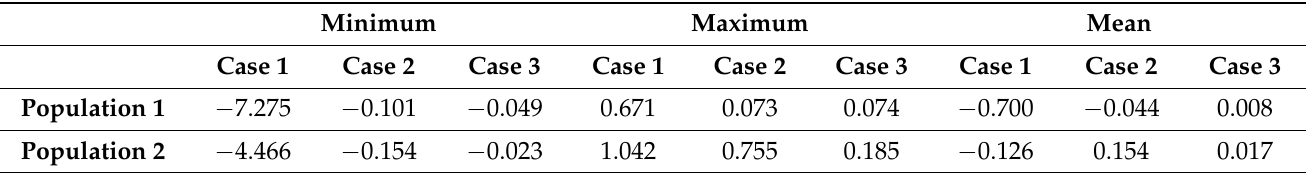
Figure 7. The difference in surface topographies between each of the EA runs and the reference solution. The legends present the colors related to a difference value in µ m. Table 3. The minimum, maximum, and mean values (in µ m) of the differences between surface topographies obtained in each of the EA run and the reference